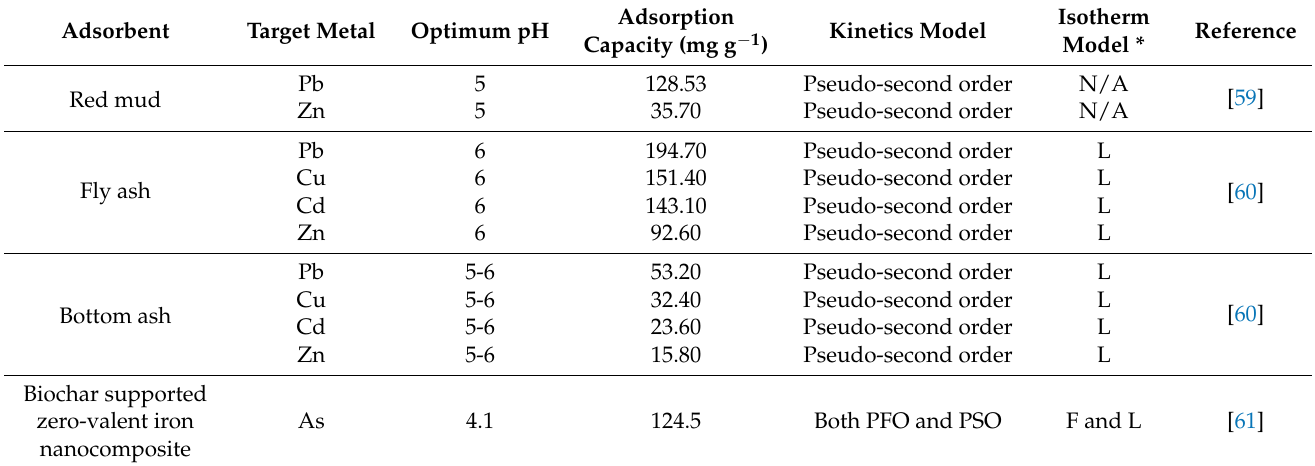
Table 11. Heavy metal adsorption capacities of various industries by product-based